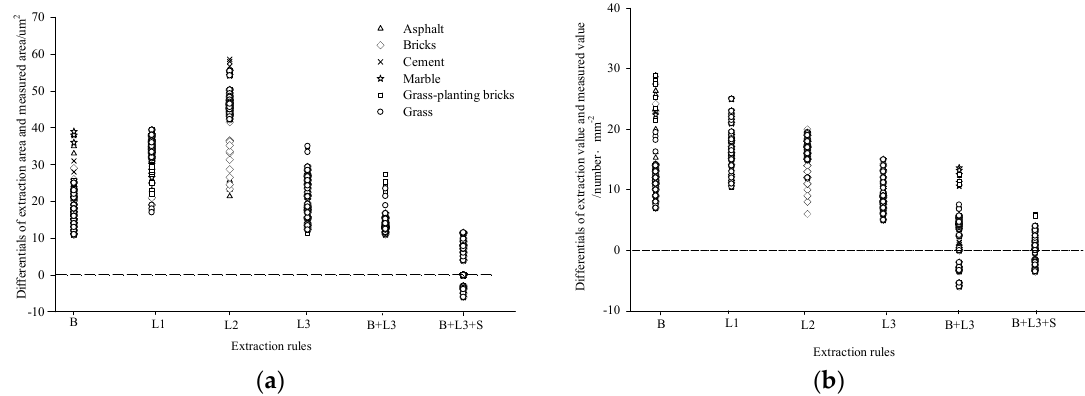
Figure 6. Scatter plot of stomatal division accuracy. B: brightness, L1: layer 1, L2: layer 2, L3: layer 3, S: shape. ( a ) Accuracy of stomatal area extraction under different rules, ( b ) Accuracy of stomatal density extraction under different rules.